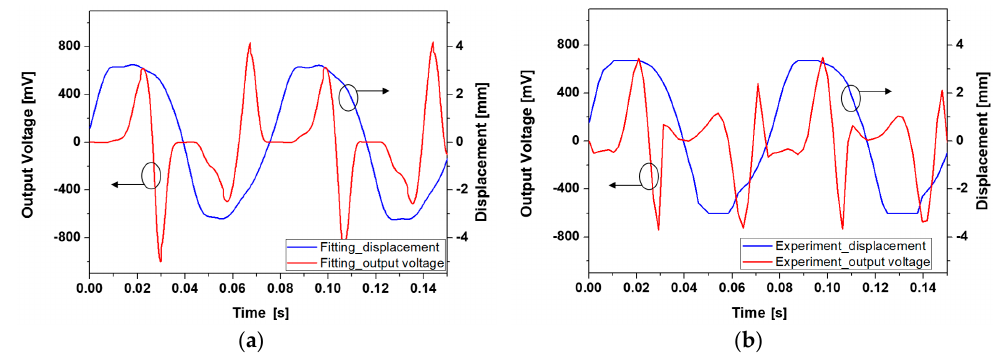
Figure 9. Comparison of the open circuit voltage waveforms: ( a ) calculated output voltage and displacement; ( b ) experimented output voltage and displacement.